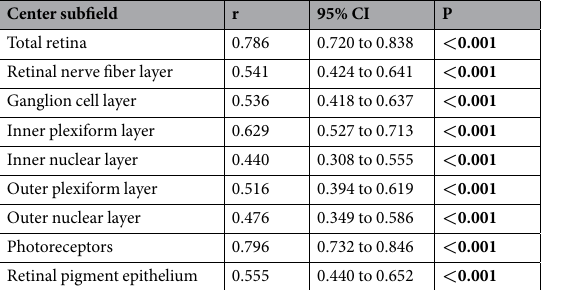
Table 5. Correlation of the axial length with the thicknesses obtained by the OCT after adjusting for the ocular magnification. CI, confidential interval. P values were yielded by Pearson correlation analysis to evaluate the effect of axial length on macular thickness (r = correlation coefficients). * Bold values indicate statistically significant differences (P <